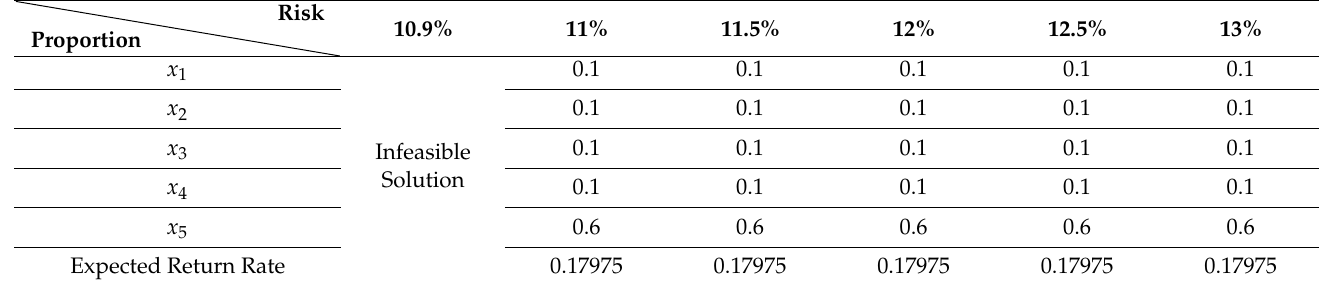
Table 12. The efficient portfolio with s = 4 in a guaranteed return rate (cid:101) p 3